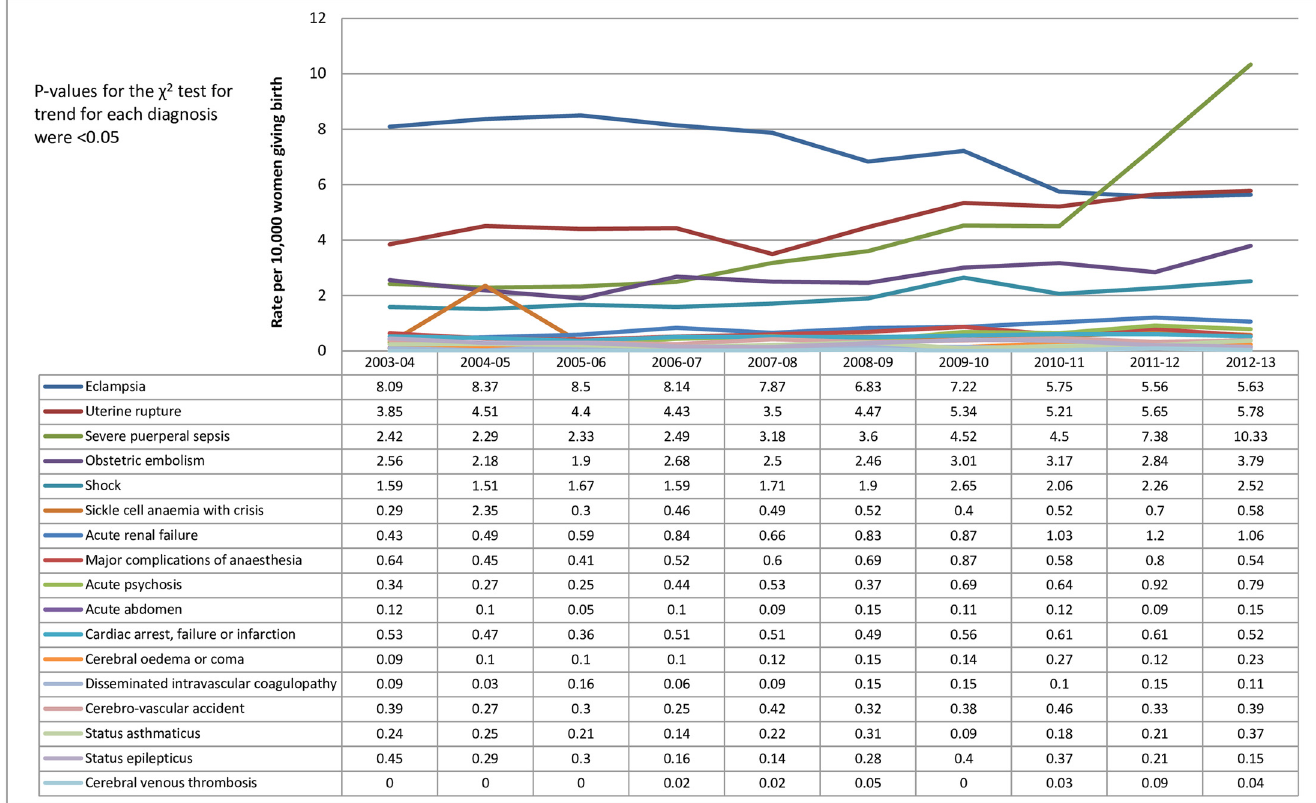
Fig 4. Annual rate per 10,000 women of the individual morbid events/ diagnoses included in the EMMOI (2003 to 2013); Hospital Episode Statistics data England.